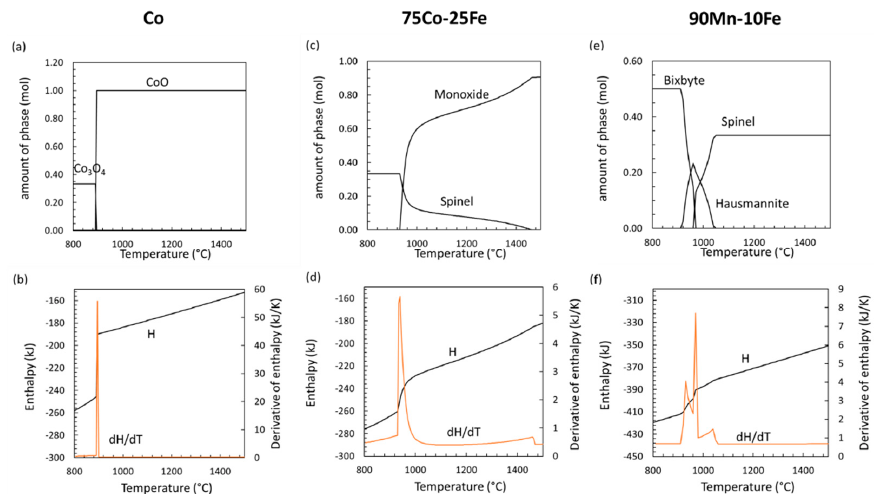
Figure 10. Calculation of the influence of temperature on ( a , c , e ) the phase assemblage evolution and ( b , d , f ) the system enthalpy, for three oxide systems in